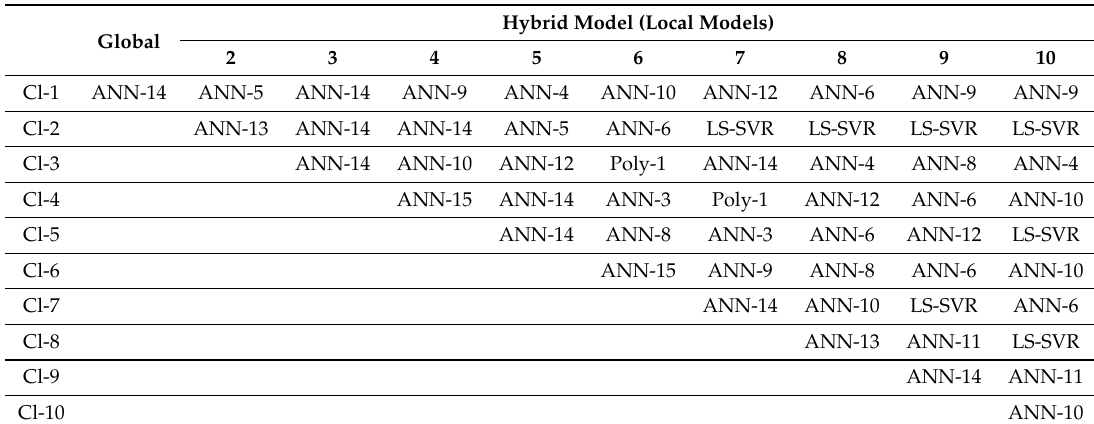
Table 7. Configuration for each individual hybrid model.